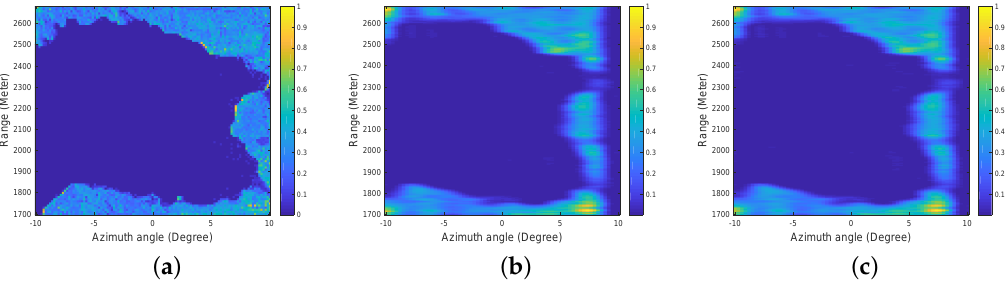
Figure 12. The simulation results when TV and FTV have the same performance. ( a ) The simulation scenario; ( b ) The TV method, t = 331.21 s; ( c ) The FTV method, t = 55.37